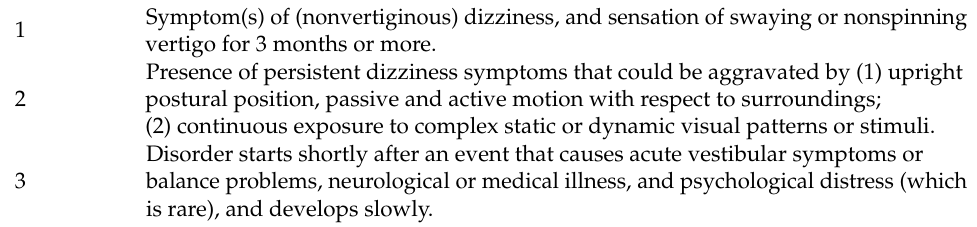
Table 1. Criteria for diagnosis of persistent postural–perceptual dizziness [6,8].